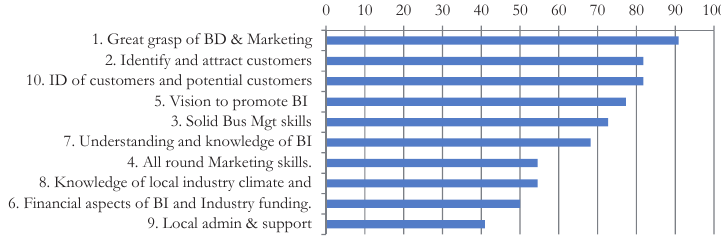
Fig. 3 – BI Managers perception of skills set required for role of BD/Marketing Manager. Source: authors. The median Marketing score was 6.0 (interquartile range (IQR) 5.4-6.6; range 4.8-7.0). The dis- tribution of the data is shown below. We see that both scores are negatively skewed; responses are predominantly towards the ‘important’ end of the rating scale.